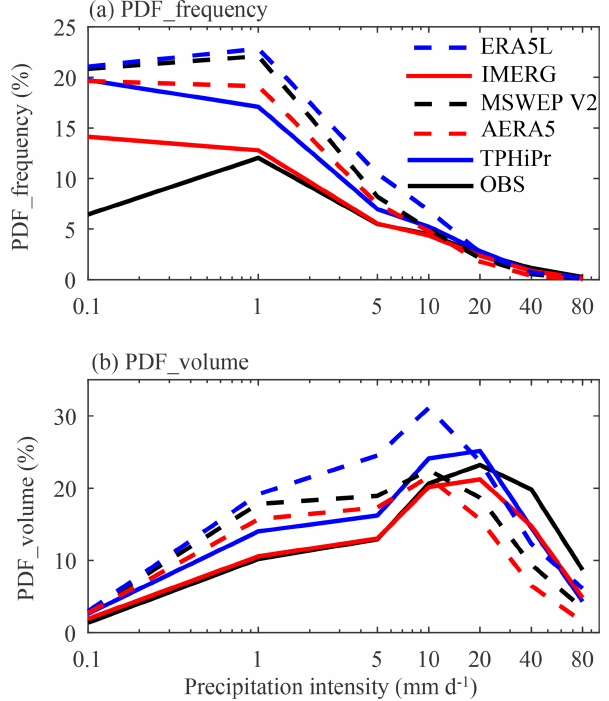
Figure 15. Comparison of the probability density function by (a) precipitation frequency and (b) amount for rain gauge data and the four datasets. The x axis is in the log